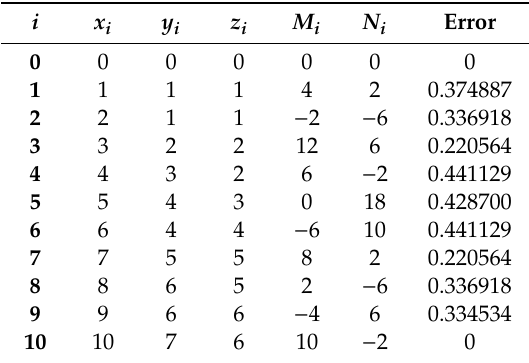
Table 2. Line generation based on this article’s algorithm.